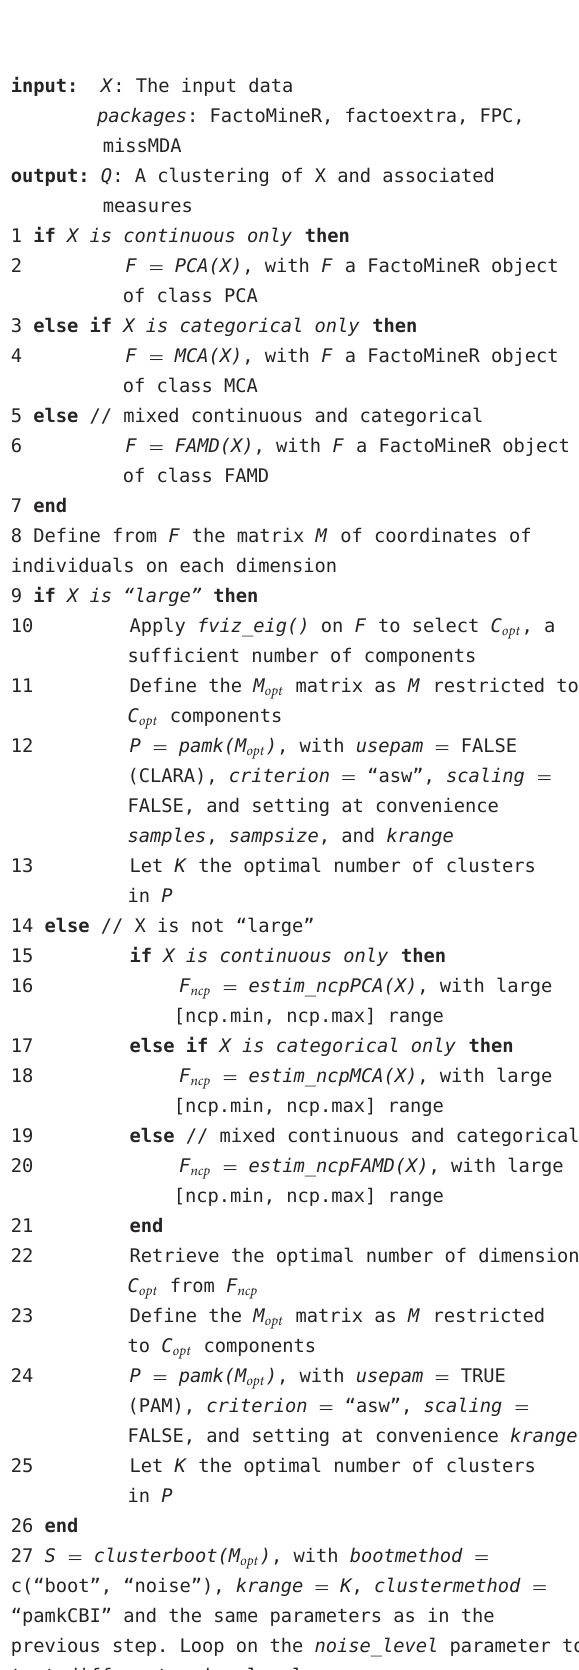
Algorithm 1. The Qluster